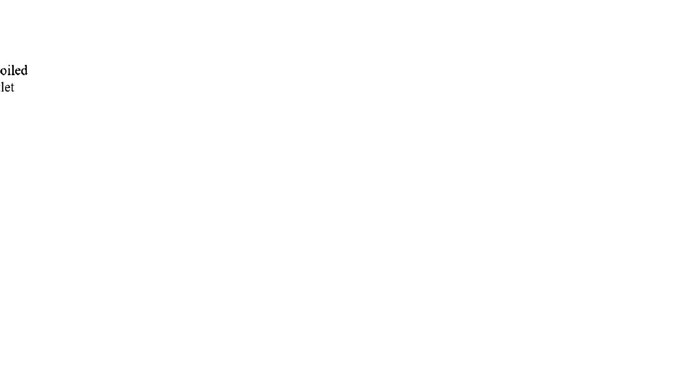
Figure 2. Schematics of eccrine sweat